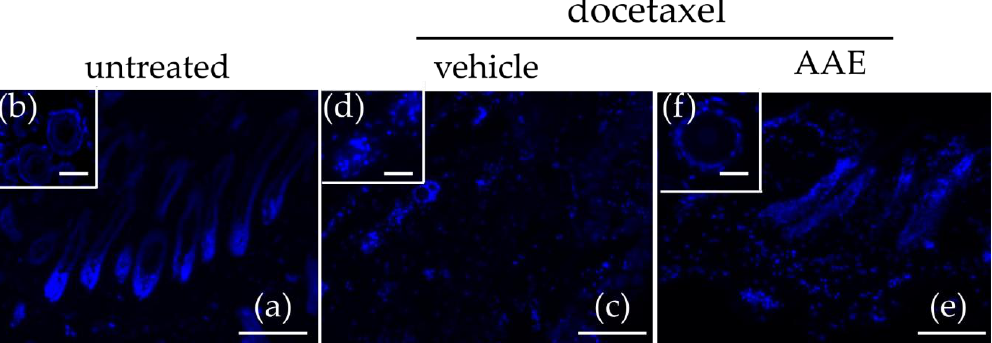
Figure 2. AAE protects murine HFs from taxanes induced dystrophy. 12 week old C57BL/6 mice were sacrificed and their skin biopsies incubated in vitro in the absence or in the presence of Docetaxel (700 nM), AAE (400 mg/L) or vehicle. Upon 7 days of ex-vivo culturing, biopsies were fixed and processed for histology. Nuclei were stained with DAPI and HFs classified following morphological criteria. ( a , b ) Untreated HFs in late Anagen phase; ( c , d ) HFs treated with Docetaxel showing severe signs of follicular dystrophy ( e , f ) HFs of mice treated with docetaxel in the presence of AAE appearing less damaged by the treatment with the taxane. Scale bars correspond to 50 µ